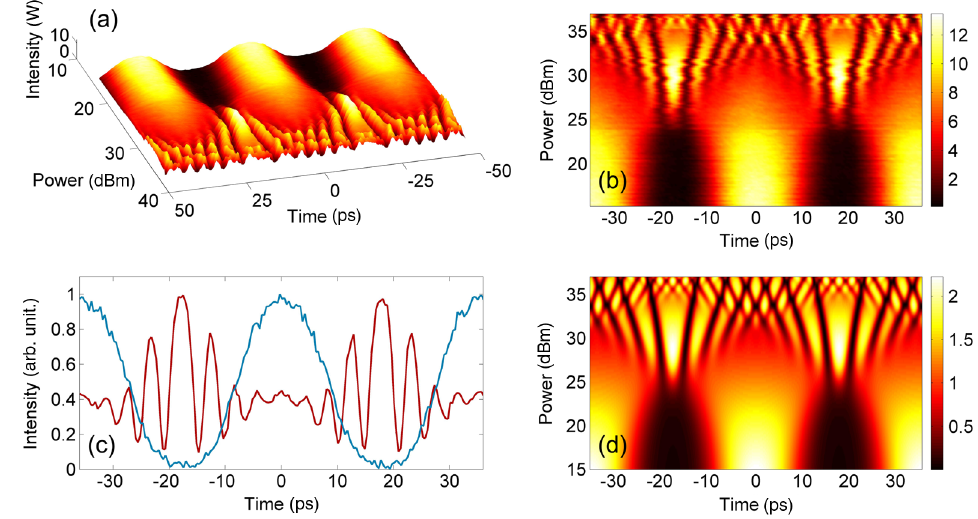
FIG. 6. As in Fig. 5, with FWM produced by the three-wave input with η ¼ 0 . 7 and α ¼ 0 . The temporal OSO trace in (c) corresponds to a power P ¼ 32